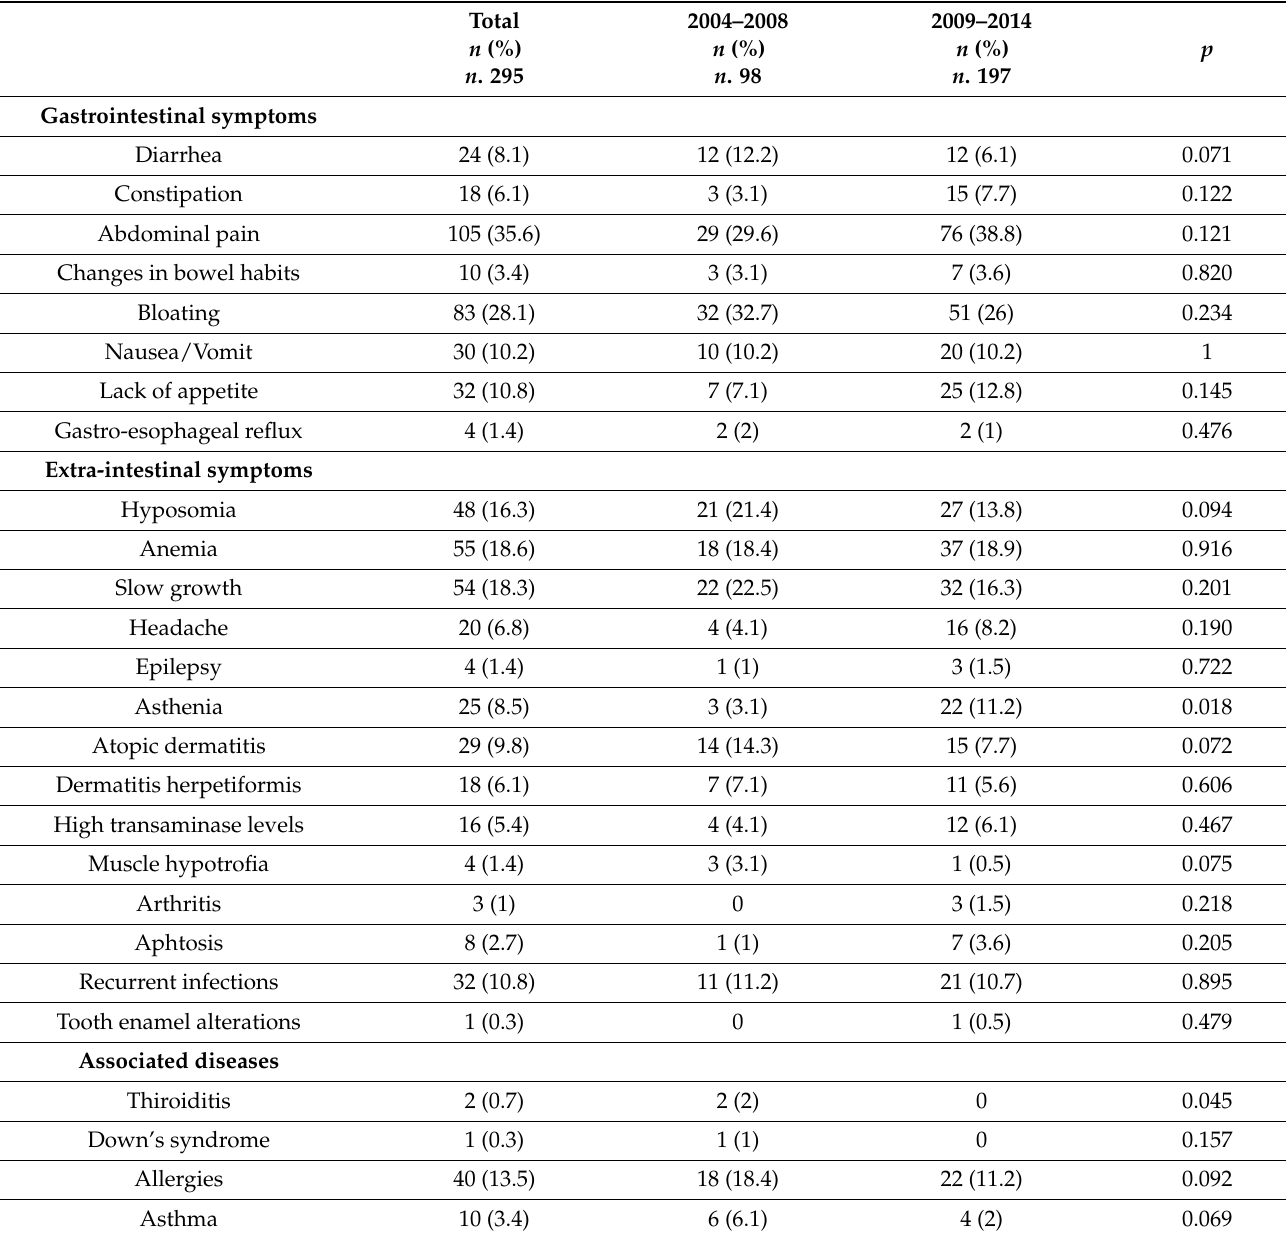
Table 2. Symptom pattern and associated diseases in symptomatic celiac disease patients ( n = 295) at diagnosis, between two consecutive five-year enrollment